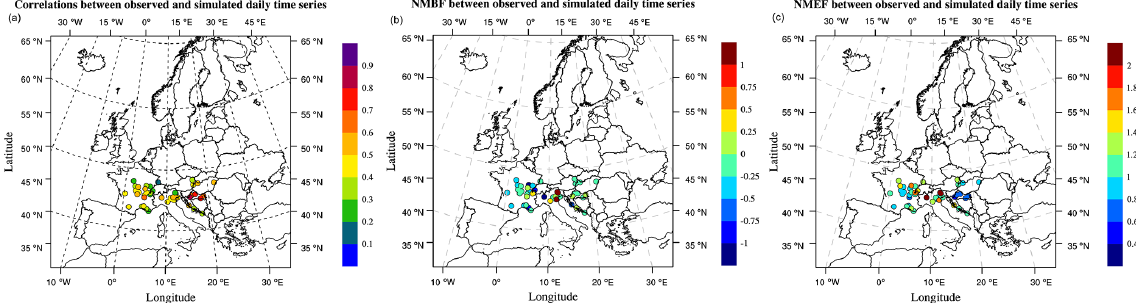
Figure 7. Statistical measures between simulated and observed daily pollen time series for each site: correlation coefficients (a) , normalized mean bias factors (b) and normalized mean error factors (c) .